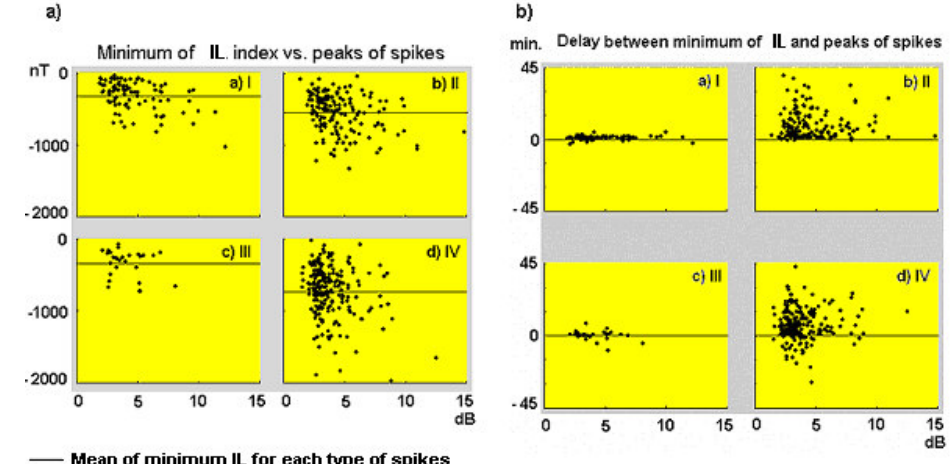
Fig. 14. (a) Scatter plot of minimum of IL index in nT versus peaks of spikes in dB for 4 types of spike events. Solid lines are the mean of minimum IL for each type. (b) Occurrence of time delay in minutes between minimum of IL index and peaks of spikes for 4 types of spike events (see Eq.